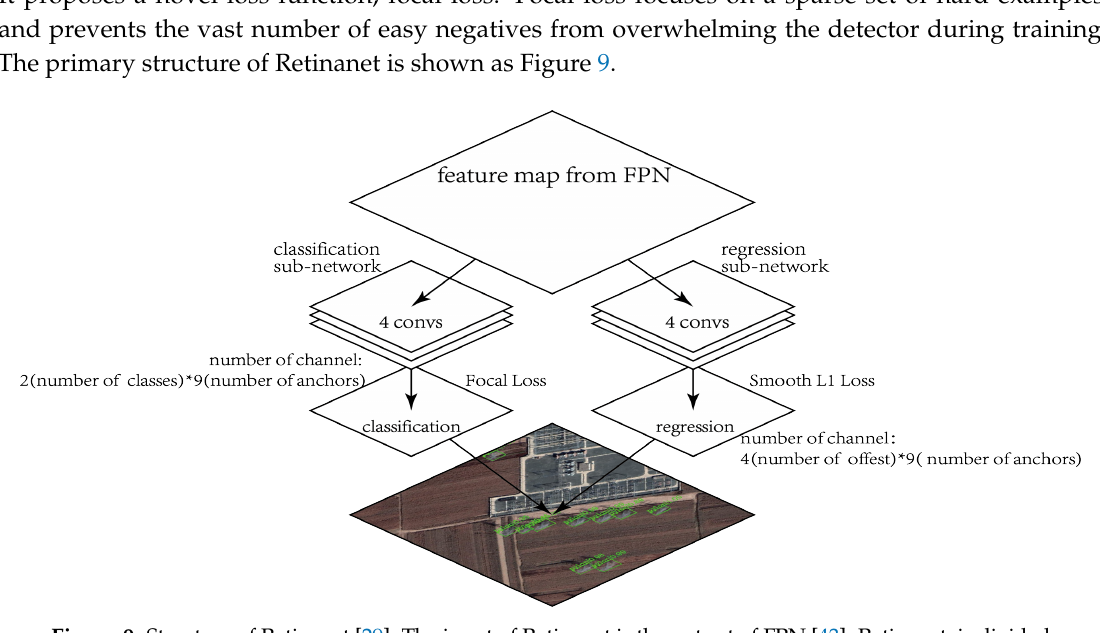
Figure 9. Structure of Retinanet [29]. The input of Retinanet is the output of FPN [43]. Retinanet is divided into classification sub-network and regression sub-network. In this paper, Classification sub-network outputs feature maps with 18 channels, equaling the number of classes multiplied by the number of anchors. Focal Loss is used in classification sub-network. Regression sub-network outputs feature maps with 36 channels, equaling the number of offsets multiplied by the number of anchors. Regression sub-network utilizes smooth L1 loss